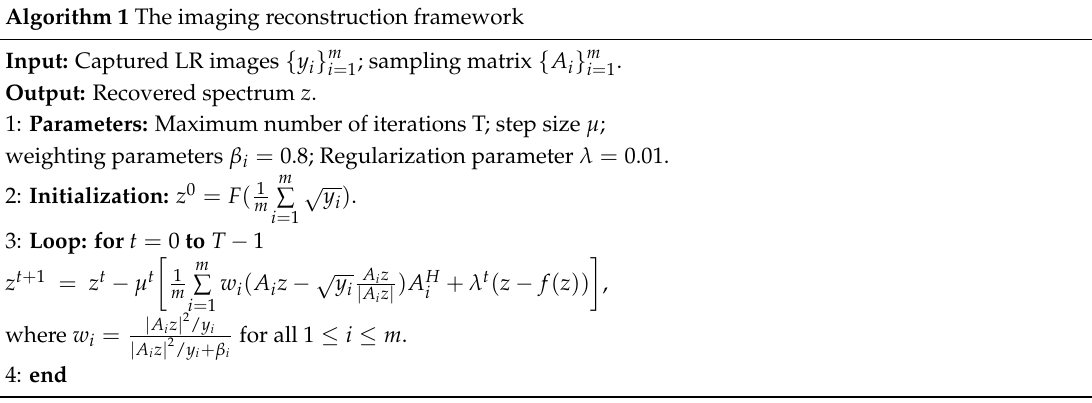
Algorithm 1 The imaging reconstruction framework